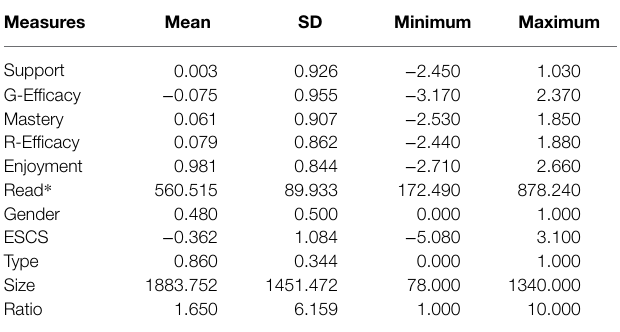
TABLE 1 | Descriptive statistics of the